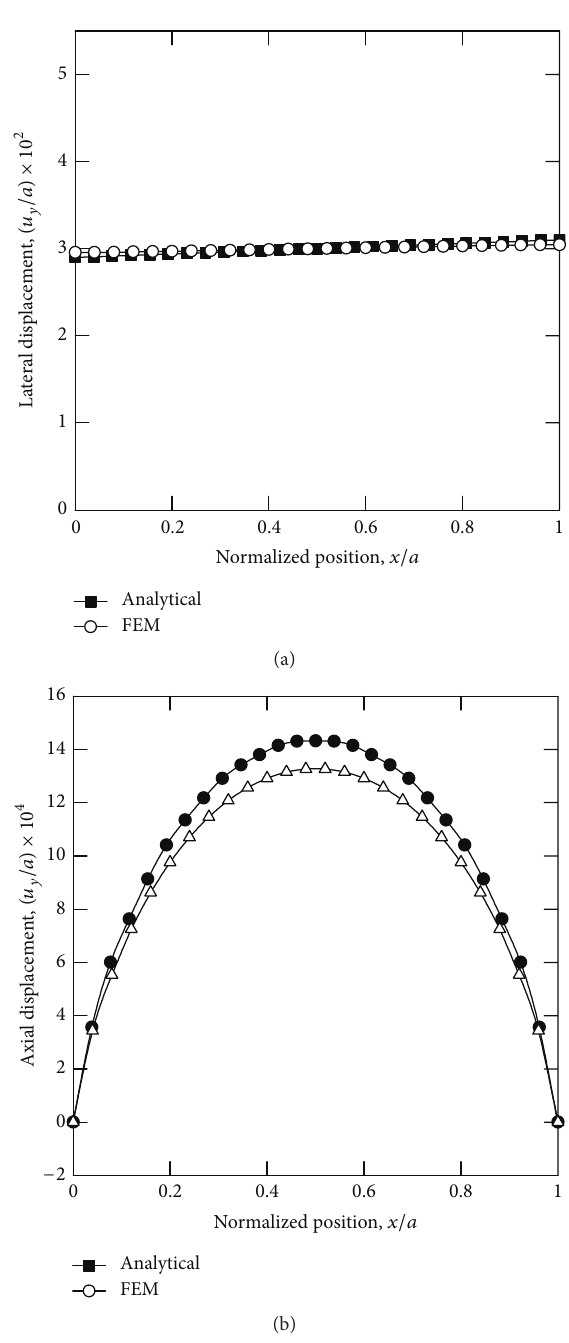
Figure 8: Comparison of solutions of different displacement com- ponents at the section 𝑦/𝑏 = 1 of the beam by analytical and FE methods: (a) lateral displacement; (b) axial